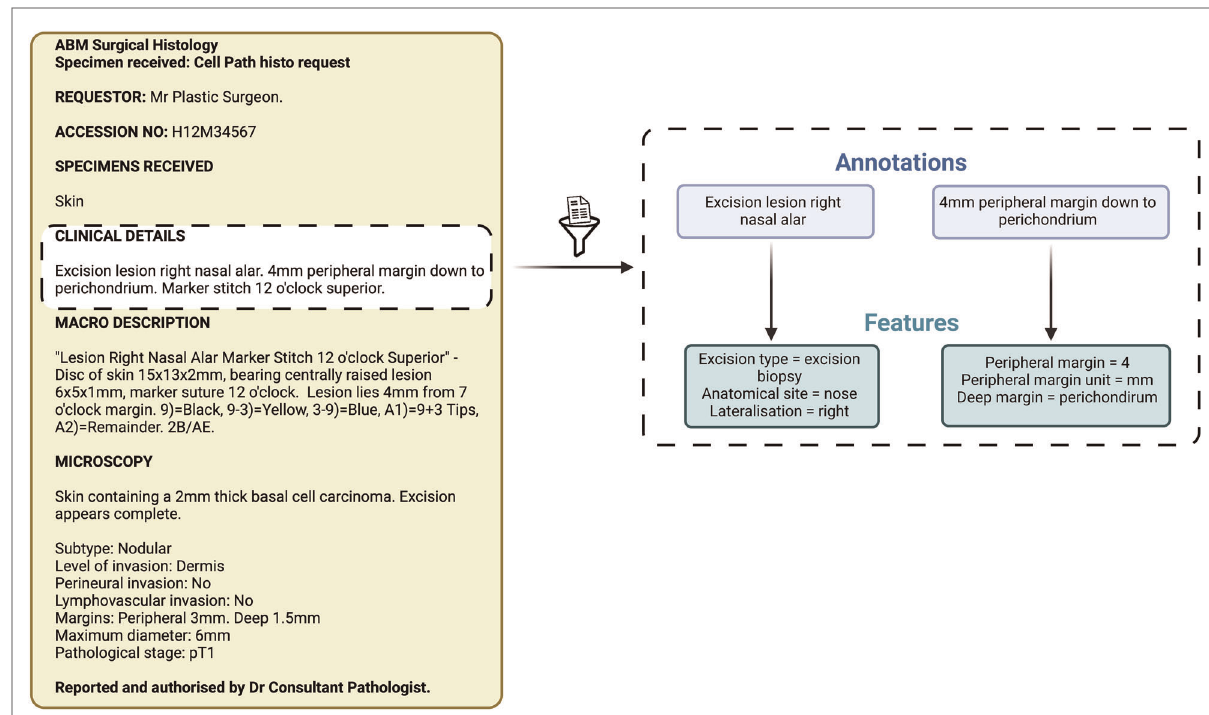
FIGURE 2 Schematic representation of annotations and features. These items of information were extracted by both the Natural Language Processing pipeline and the expert manual review.